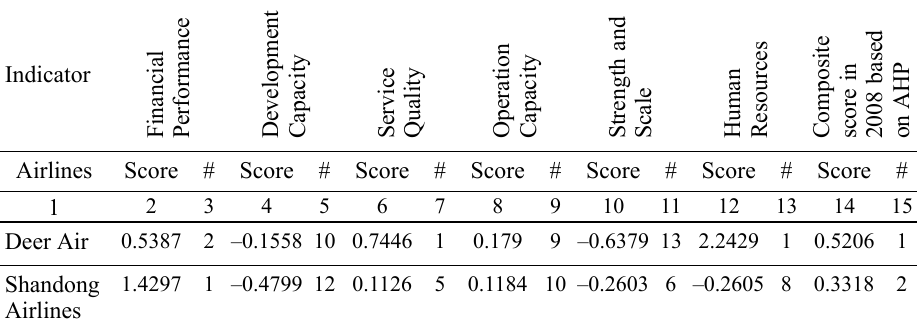
Table 11. Score & Ranking of Airline Competitiveness in 2008 based on